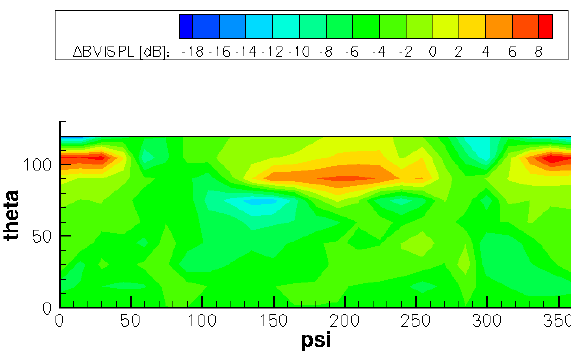
Figure 16: Technique A – C differential BVISPL at point 3 in maneu- ver ID8021.